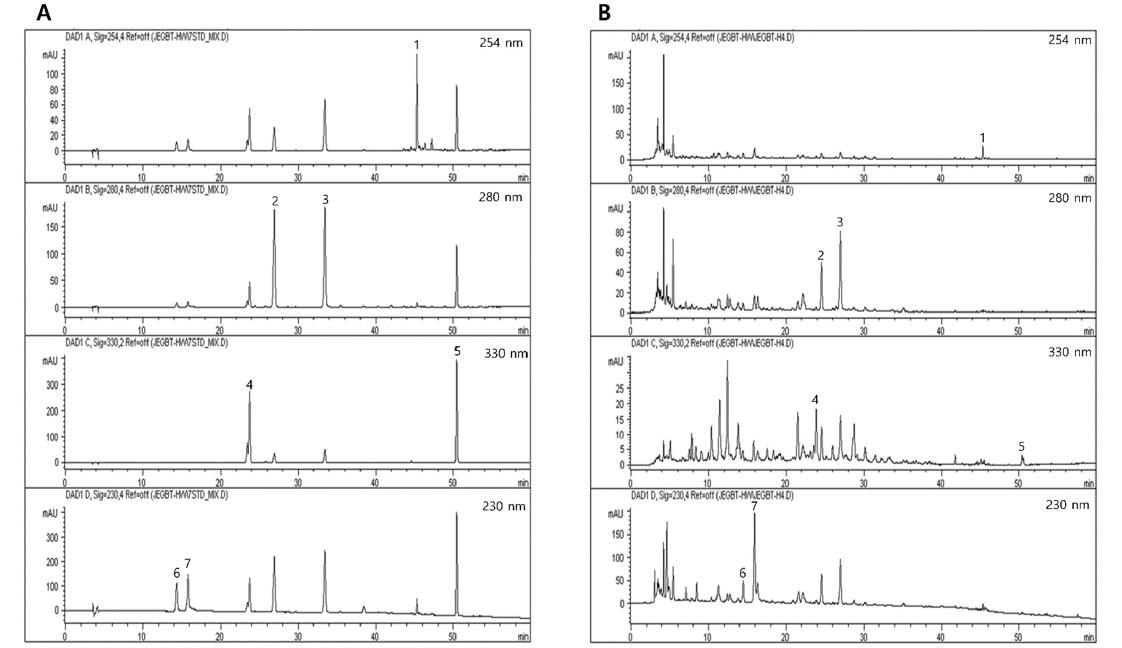
Figure 3. HPLC chromatogram of JGT for fingerprinting analysis. JGT and its reference standards chemical compounds were subjected to HPLC analysis. Fingerprinting analysis of ( A ) a total of 7 kinds of reference chemical compounds and ( B ) JGT. 1. Glycyrrhizinic acid; 2. hesperidin; 3. liquritigenin; 4. nodakenin; 5. decursin; 6. albiflorin; and 7. paeoniflorin, respectively.